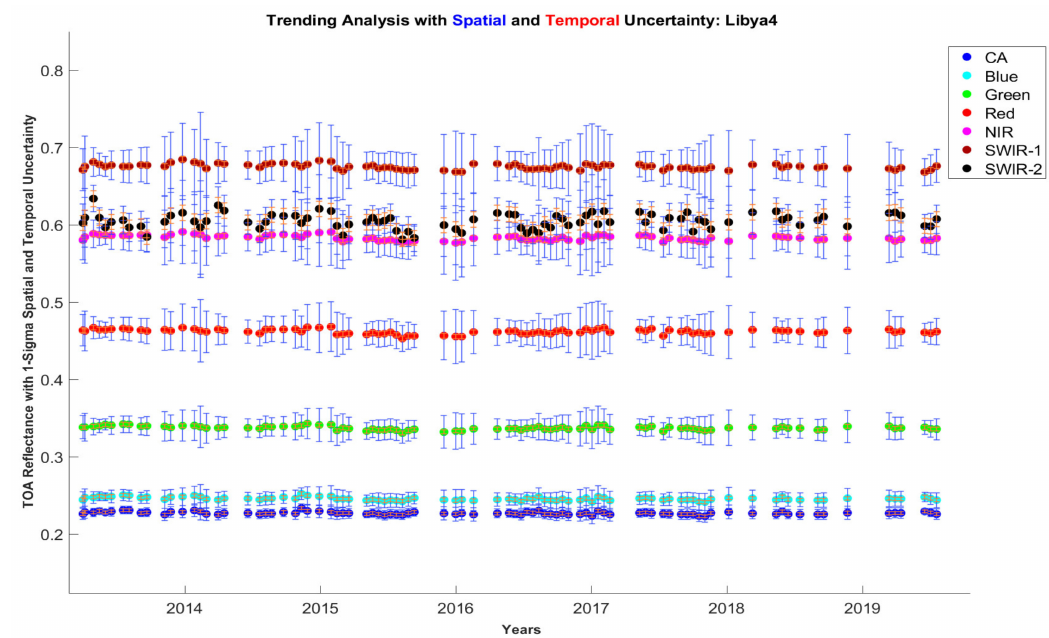
Figure 2. Trending of Landsat 8 OLI using Libya 4 PICS. Each set of data represents a spectral band. Uncertainties shown include estimates of both temporal and spatial